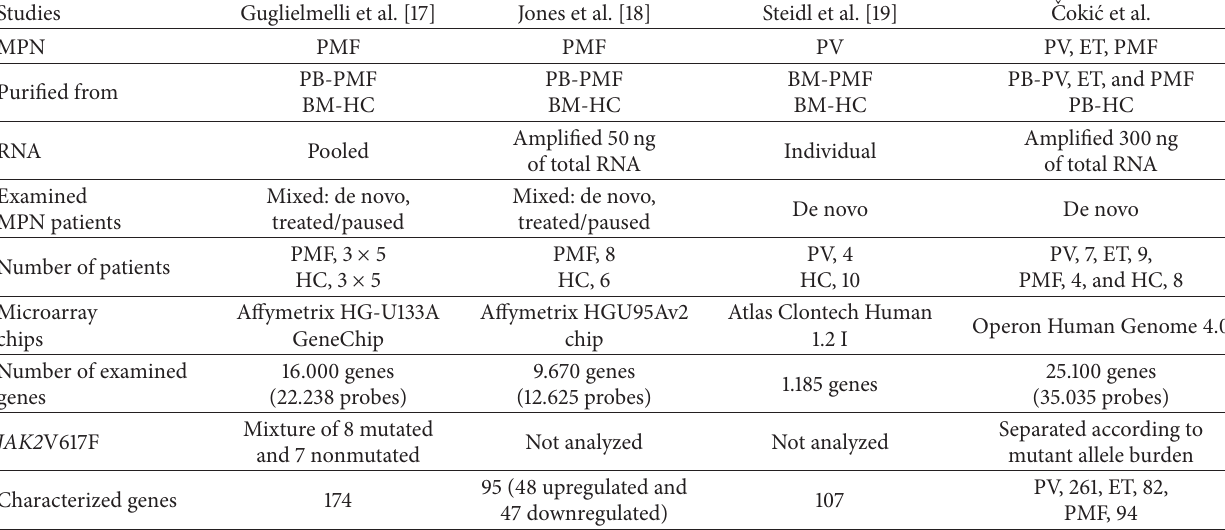
Table 4: Comparison of gene expression profiling between former and present studies in CD34 + cells of MPN subjects. Studies